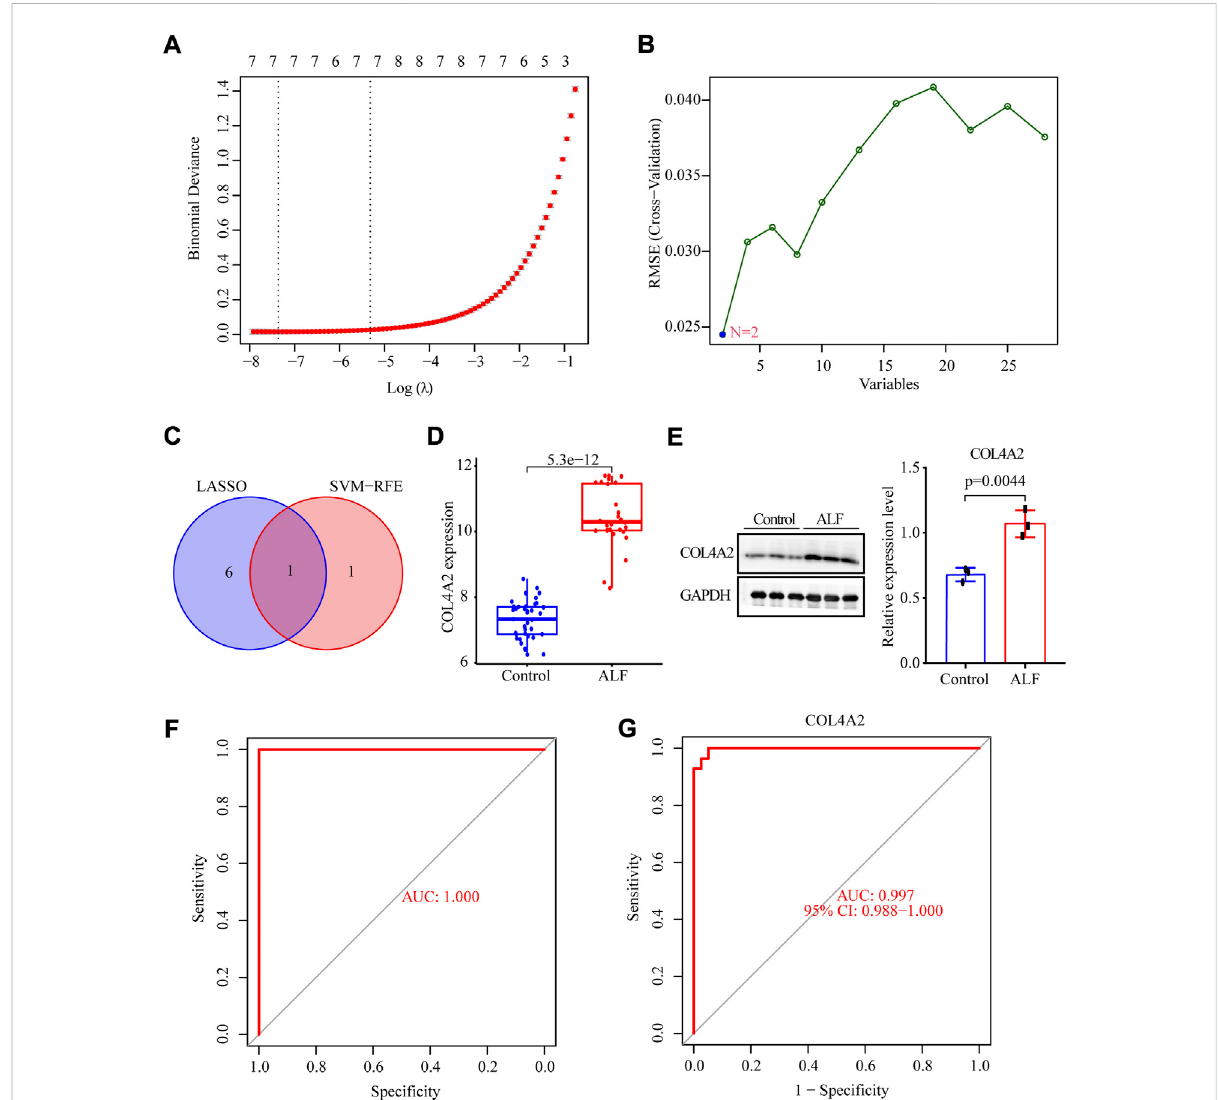
FIGURE 5 Identi fi cation of diagnostic biomarker of ALF via the comprehensive strategy. (A) LASSO logistic regression algorithm to screen diagnostic markers. (B) SVM-RFEalgorithmtoscreenbiomarkers. (C) VenndiagramtoidentifyintersectedDIAGNOSTICbiomarkersscreenedbytheLASSOand SVM-RFE. (D) The expression level of COL4A2 in thevalidation set. (E) The proteinlevelsof COL4A2 in normal and ALF mice models. The ROC curve of the gene signature in the testing set (F) and validation set (G)